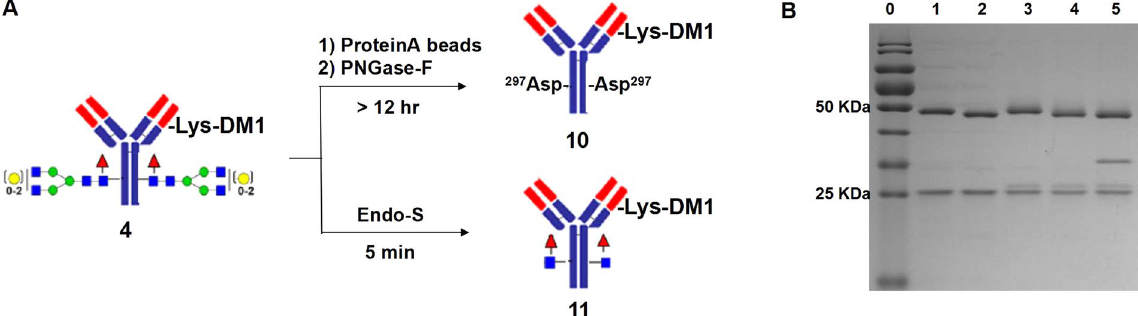
Figure 2. ADC deglycosylation with PNGase-F and Endo-S. A) Schematic procedures for ADC deglycosylation with PNGase-F and Endo-S; B) SDS-PAGE analysis of ADC deglycosylation, lane 0: protein